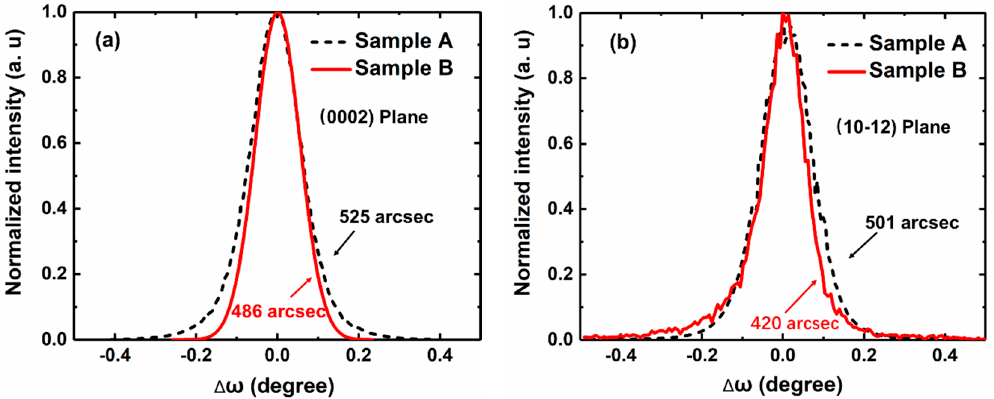
Figure 6. X-ray rocking curves of samples A and B on ( a ) (0002) and ( b ) (10–12) reflections.